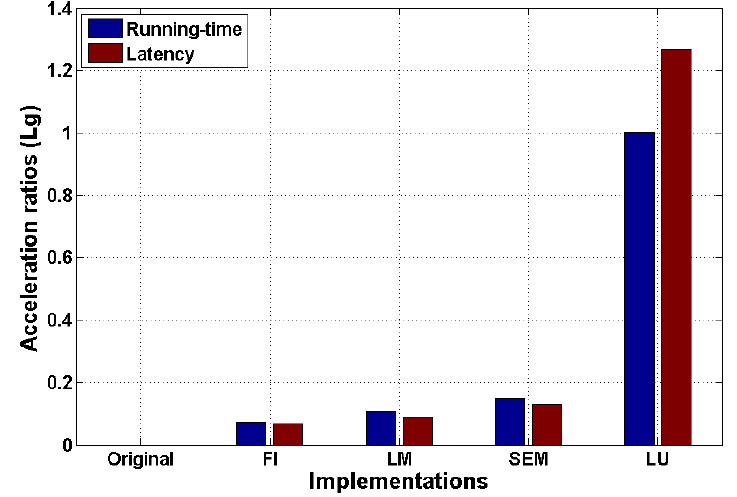
Figure 8. Running time and latency acceleration improvement of different optimized